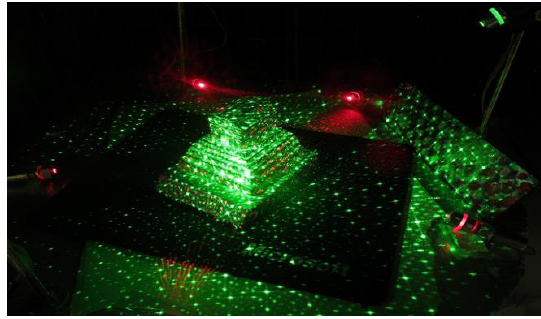
Figure 4–The dot patterns projected on the object 3-1 Imaging Network Design for the